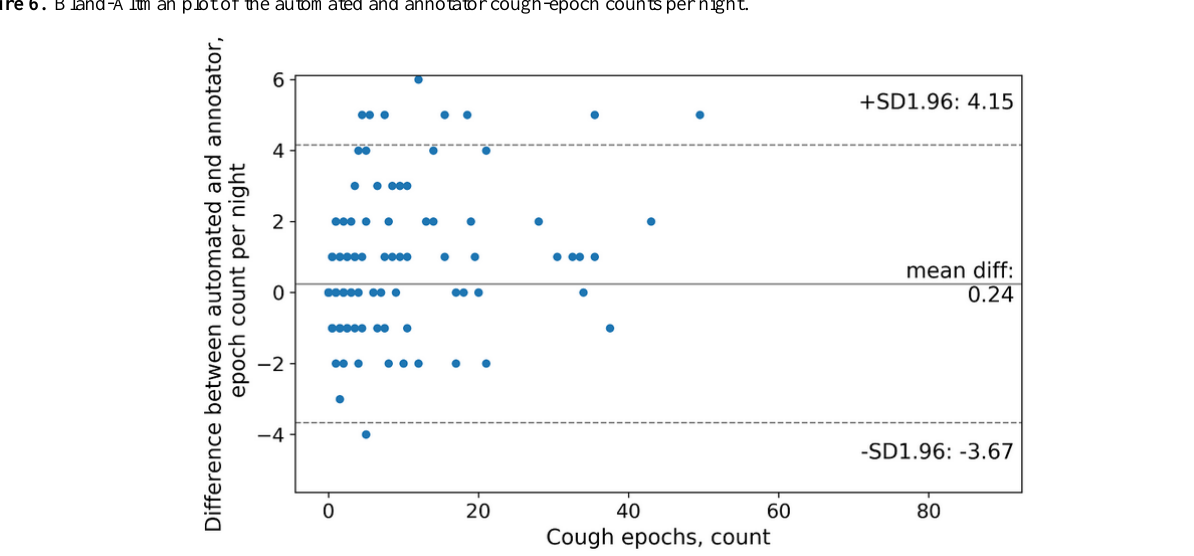
Figure 6. Bland-Altman plot of the automated and annotator cough-epoch counts per